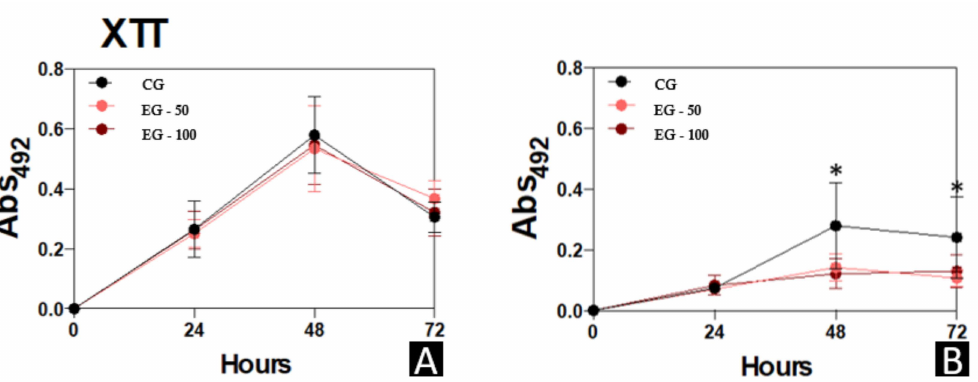
Figure 6. Biofilm formation by C. albicans and S. mutans for 24, 48, and 72 h at 37 ◦ C. ( A ), C. albicans . ( B ), S. mutans. At each time point evaluated, the systems were processed to detect metabolic activity by reducing XTT in menadione by viable cells at 492 nm. Results are expressed as the mean ± standard deviation of three independent replicates. * p < 0.05.